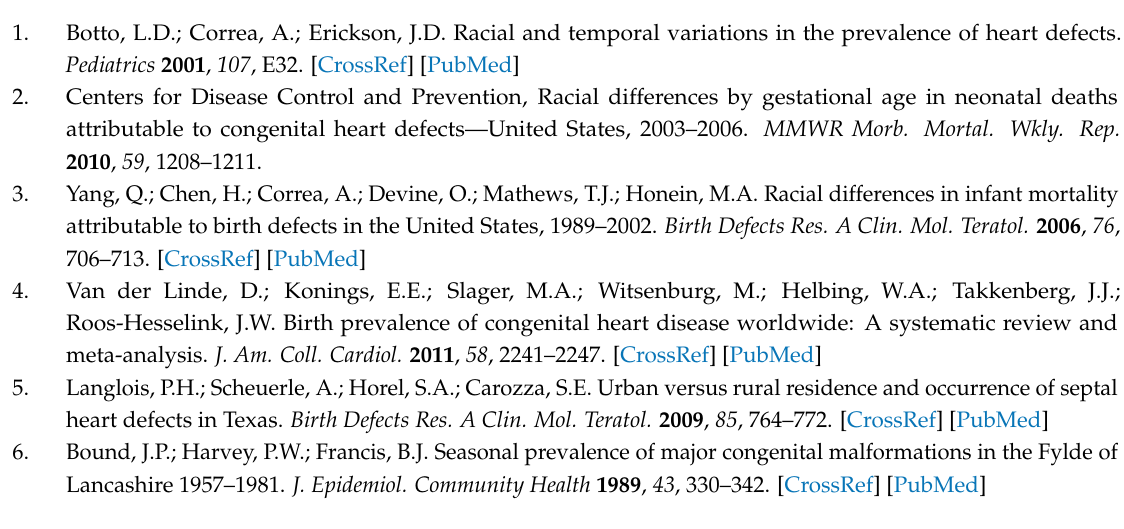
Table S1: Descriptive characteristics of cases and controls with available atrazine data, NBDPS, 1999–2005, Table S2: Descriptive characteristics of all potential controls with and without atrazine data in NBDPS,